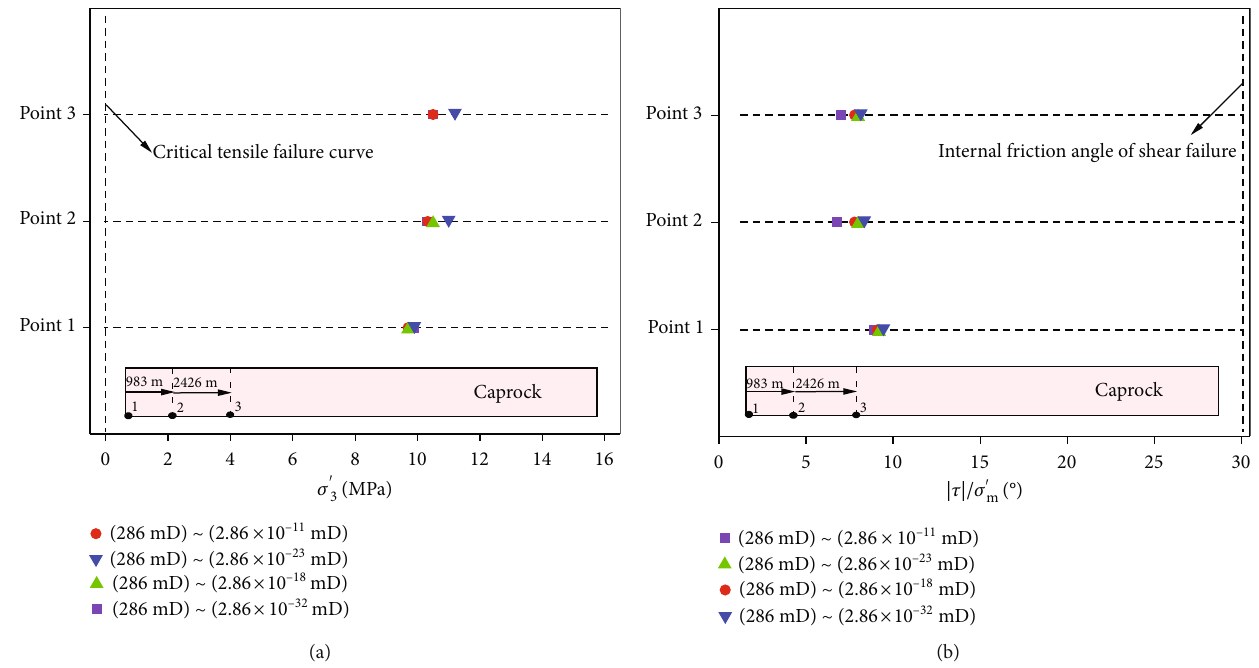
Figure 26: In fl uence of reservoir boundary on mechanical integrity of caprock. (a) The minimum principal stress. (b) Critical internal friction